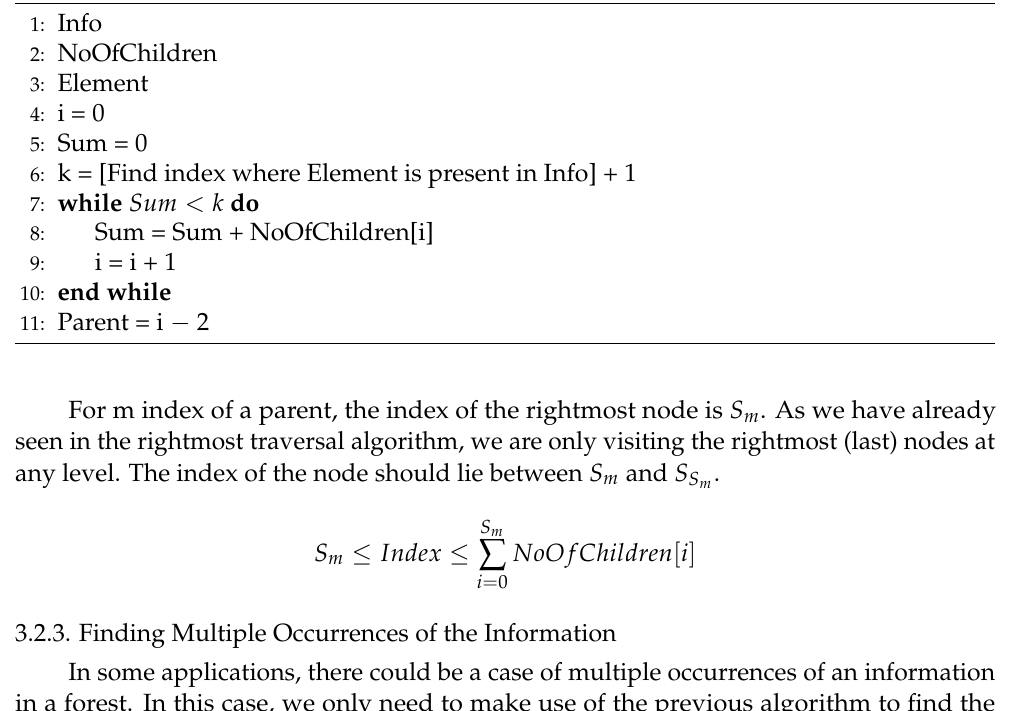
Algorithm 2 Finding the parent node